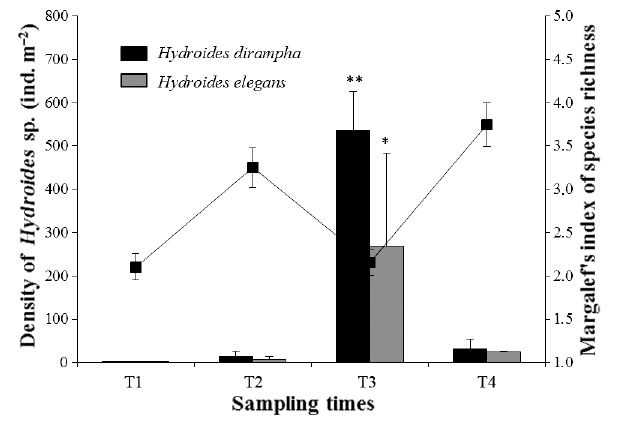
Fig. 6. Mean (±SE) densities of non-indigenous Hydroides spp. (bars) and the Margalef’s species richness index (calcu- lated excluding the 2 serpulid species) for the 4 sampling times (see Fig. 1). Significant highest values of density were reported for the 2 serpulids at T3 (*p < 0.05, **p < 0.01)